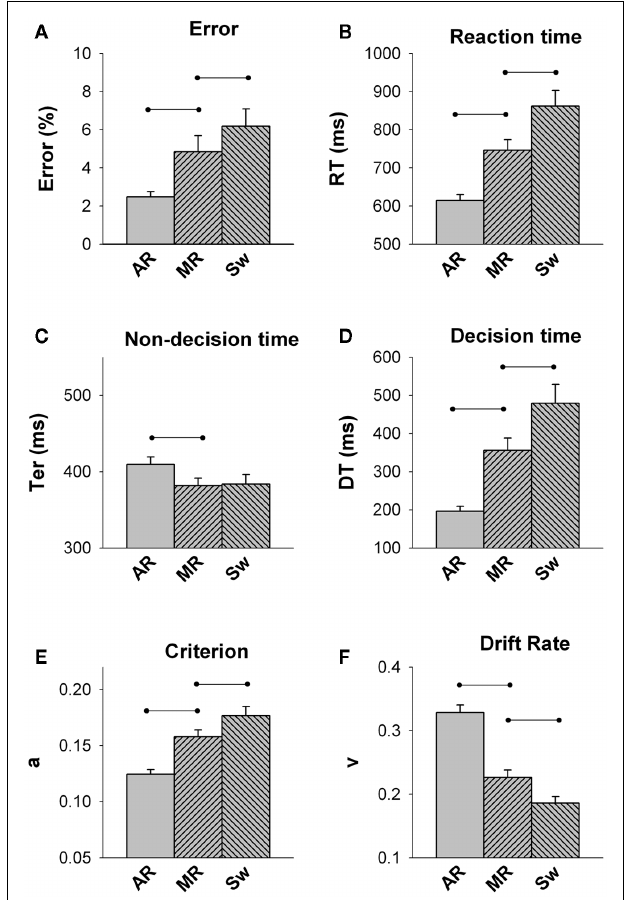
FIGURE 2 |Average error rate (A), reaction time (B), non-decision time (C), decision time (D), criterion (E) and drift rate (F) for each trial type in theYoung group (18–29y;AR = all-repeat, MR = mixed-repeat, S = switch). Lines represent significant